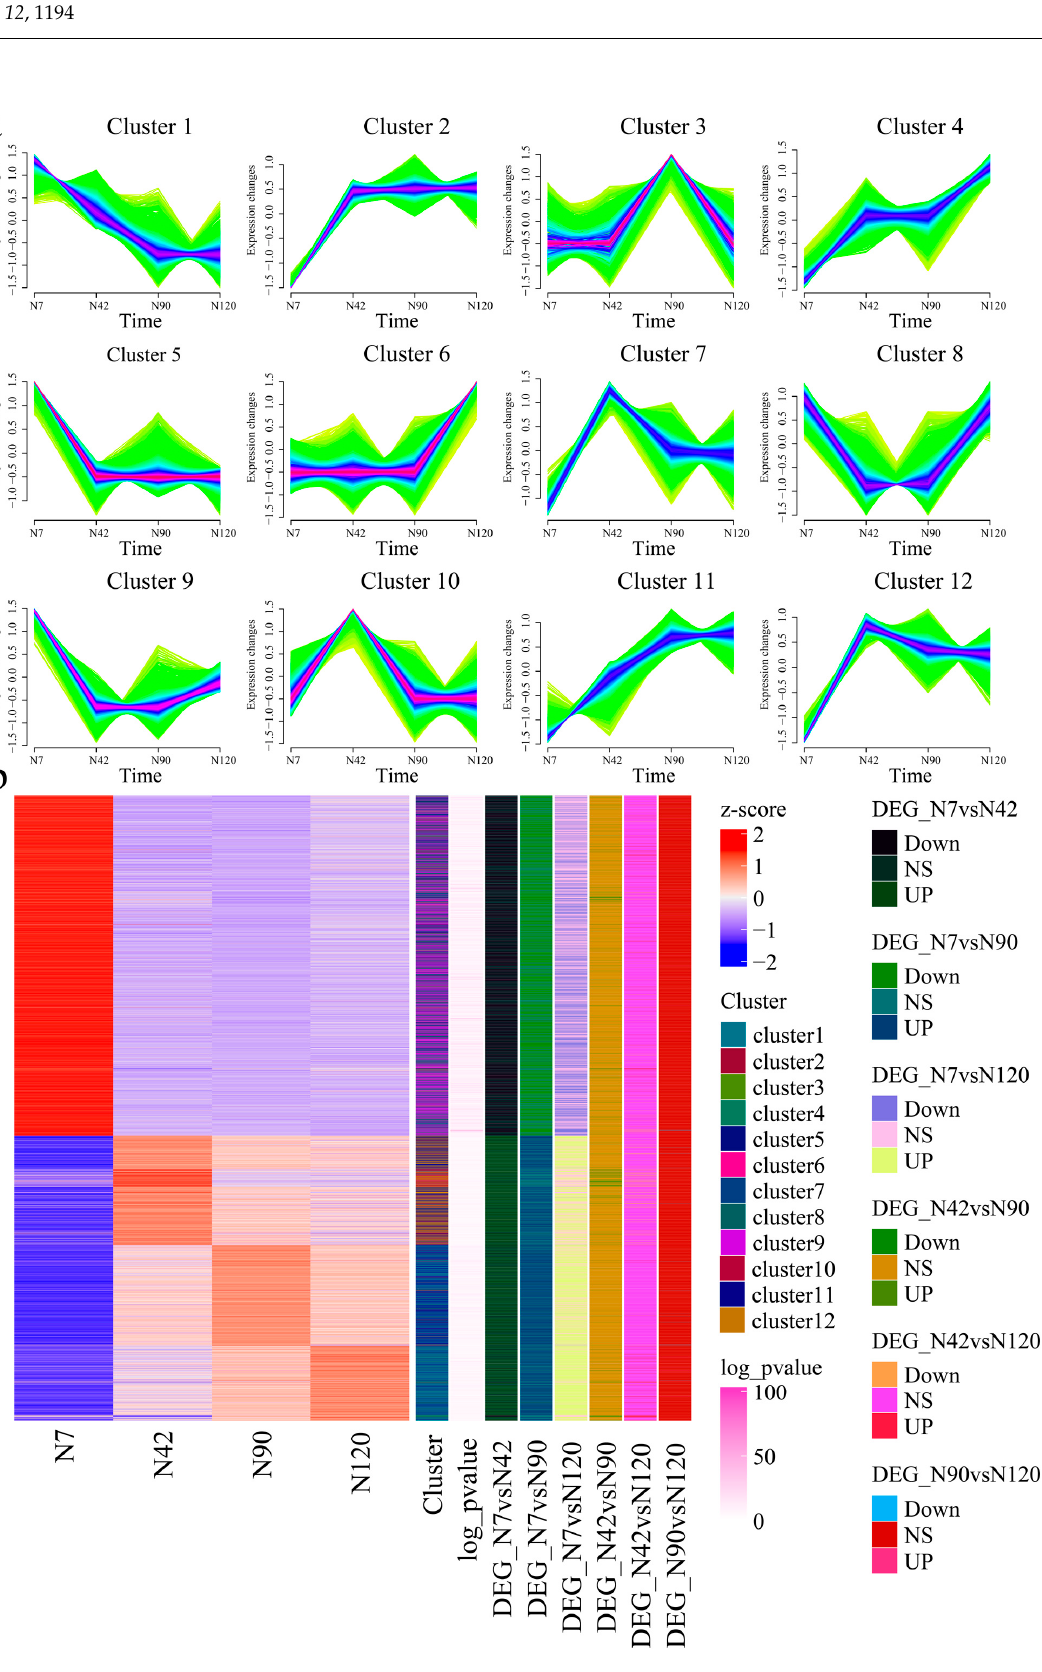
Figure 6. Transcriptome-wide time series cluster of DEGs. ( a ) Cluster analysis of DEGs based on Mfuzz. ( b ) The dynamic changes in RNA sequencing (RNA-seq) are sequentially